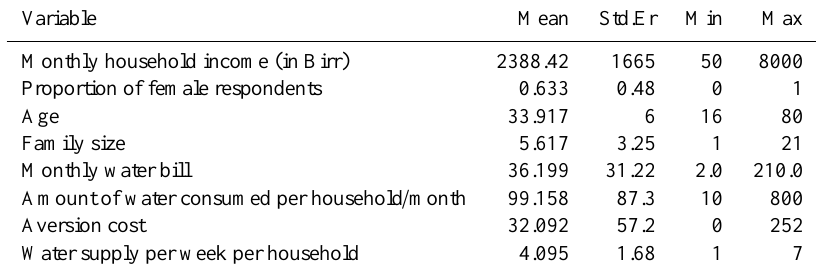
Table 2. Sample characteristics.